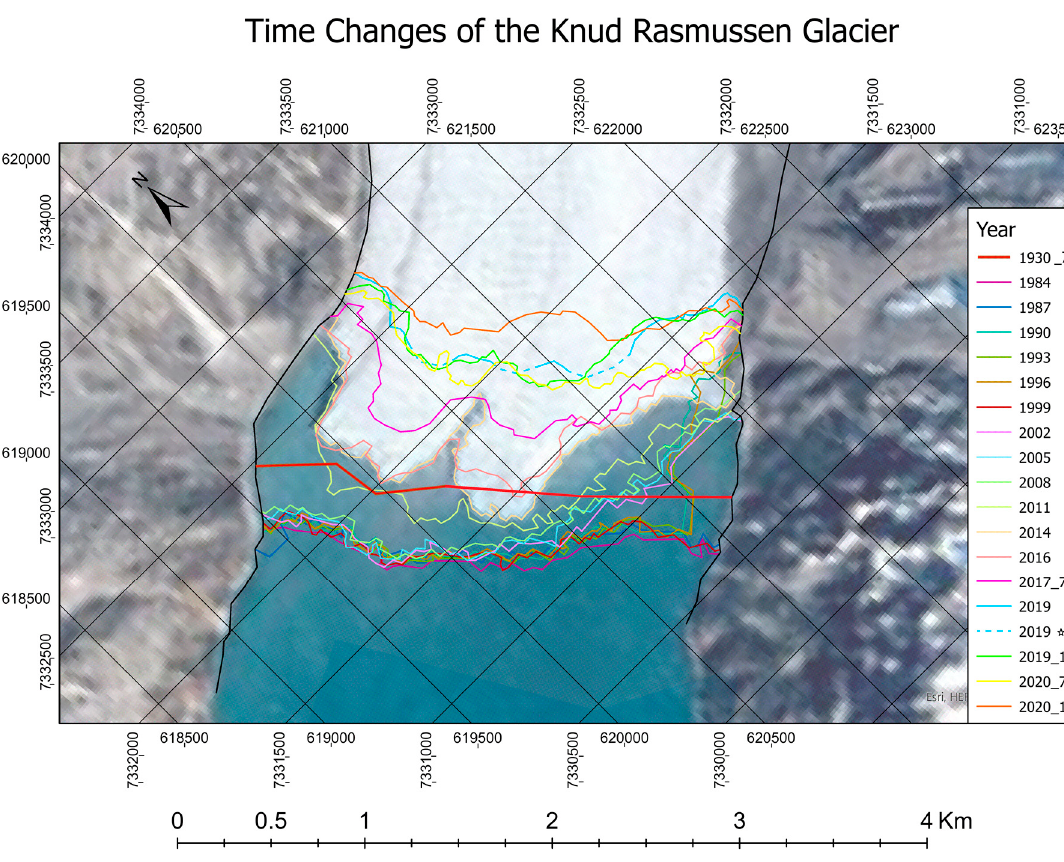
Figure 22. A final interpretation of the Knud Rasmussen Glacier changes between 1932 and 2020 (2019 * are data from the eBee drone, some parts were missing).